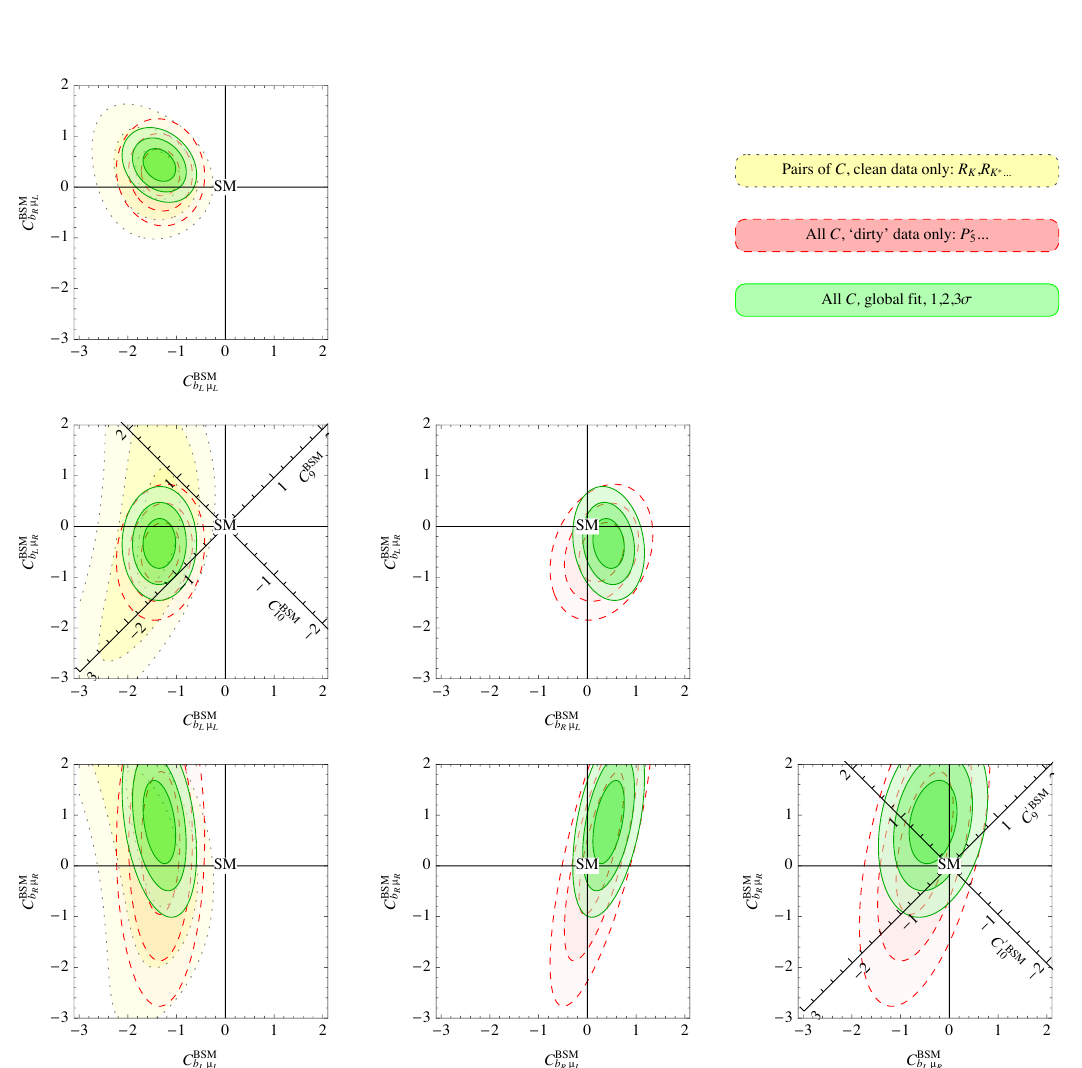
Figure 3 . Fit to the new-physics contribution to the coe(cid:14)cients of the 4 muon operators ((cid:22) b(cid:13) (cid:22) P X s )((cid:22) (cid:22)(cid:13) (cid:22) P Y (cid:22) ), showing the 1 ; 2 ; 3 (cid:27) contours. The yellow regions with dotted contours show the best (cid:12)t to the ‘clean’ observables only; due to the scarcity of data, in each plot we turn on only the two coe(cid:14)cients indicated on its axes. The red regions with dashed contours show the best global (cid:12)t to the ‘hadronic sensitive’ observables only, according to one estimate of their theoretical uncertain- ties; in this (cid:12)t, we turn on all 4 muon operators at the same time and, in each plot, we marginalise over the coe(cid:14)cients not shown in the plot. The green regions show the global (cid:12)t, again turning on all 4 muon operators at the same time. In (cid:12)gure 5 we turn on the extra 4 electron operators too.